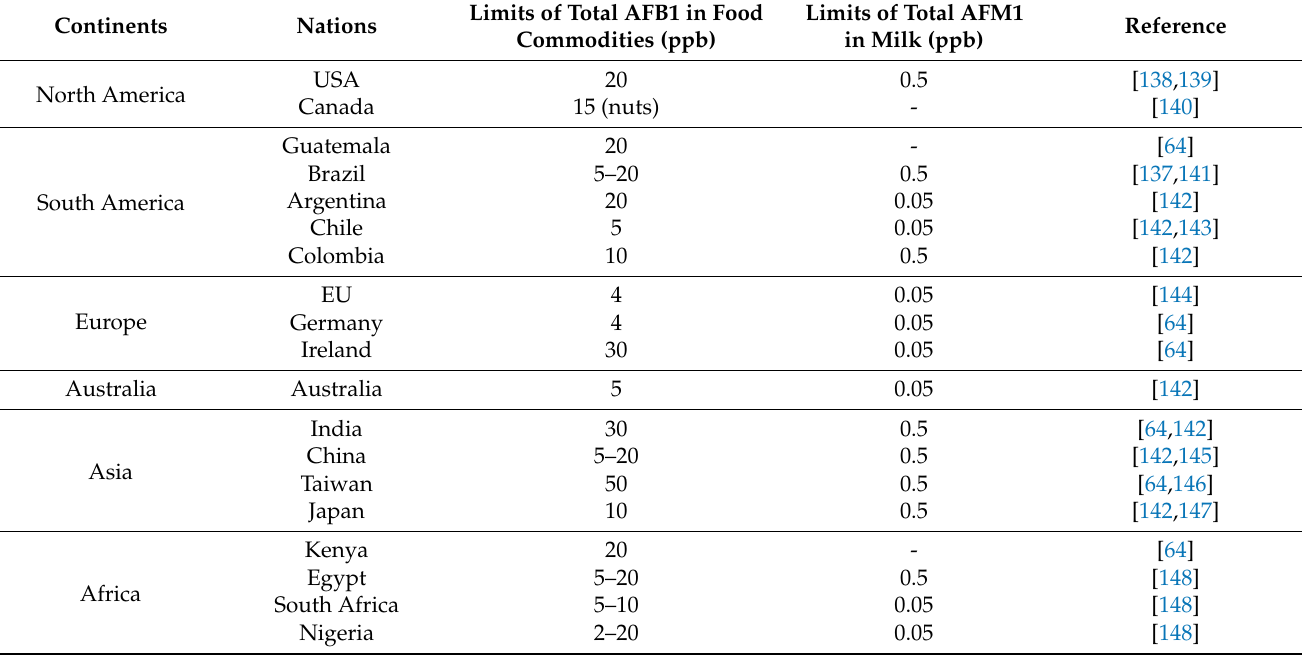
Table 2. The maximum permissible level of aflatoxins in food/feed according to the regulations of each